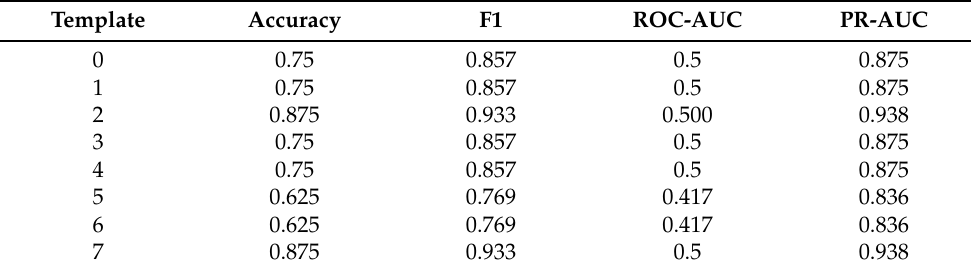
Table 4. Classification in eight test data of unipolar voltage on 1Y re AF through